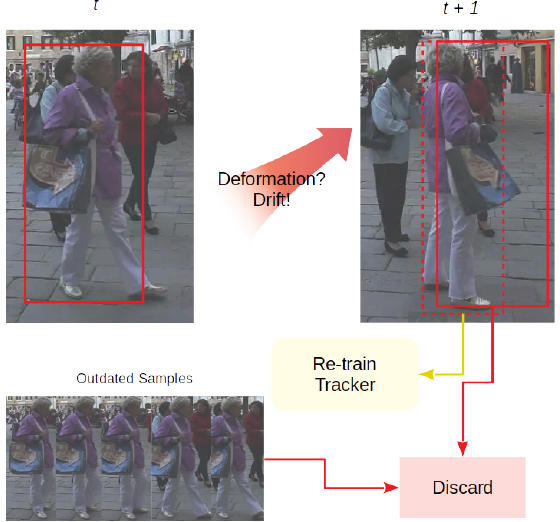
Figure 3. An illustration of the re-initiation phase in the proposed delay processing model. When deformation happens in an upcoming timestamp t + 1, the single object tracker may suffer the drift problem as shown in the solid box. The proposed method will re-train the single object tracker using a new detection (denoted by the dotted box) and discard outdated appearance